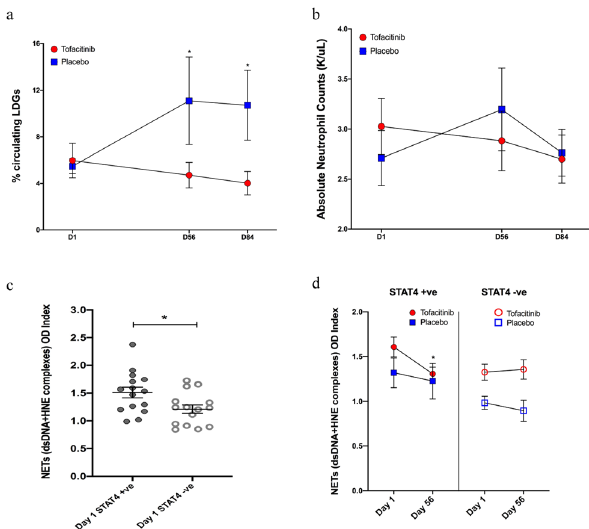
Fig. 2 Circulating LDGs and NETs are modulated by tofacitinib. a Results represent changes in percentage of circulating LDGs: Subjects treated with tofacitinib vs. placebo. Signi fi cant decrease in LDGs in tofacitinib group P = 0.048 at day 56 and P = 0.014 at day 84 using unpaired t test. b Changes in absolute neutrophil counts. c Circulating NET levels at baseline: Individuals positive for STAT4 risk allele (each subject represented by closed circles) have enhanced circulating NET levels (assessed by human neutrophil elastase (HNE)-dsDNA complexes) then subjects who are STAT4 risk allele negative (each subject represented by open circles) P = 0.02 using unpaired t test. d Changes in circulating NET levels during the study: Patients who are STAT4 risk allele positive and receive tofacitinib display signi fi cant decrease in circulating NET complexes P = 0.037 using unpaired t test. Source data are provided as a Source Data fi le. All data represent mean ± SEM, * P < 0.05, and are based on tofacitinib n = 20, placebo n = 10. Unpaired two-tailed, t test were used for all results. No adjustments were made for multiple comparisons.